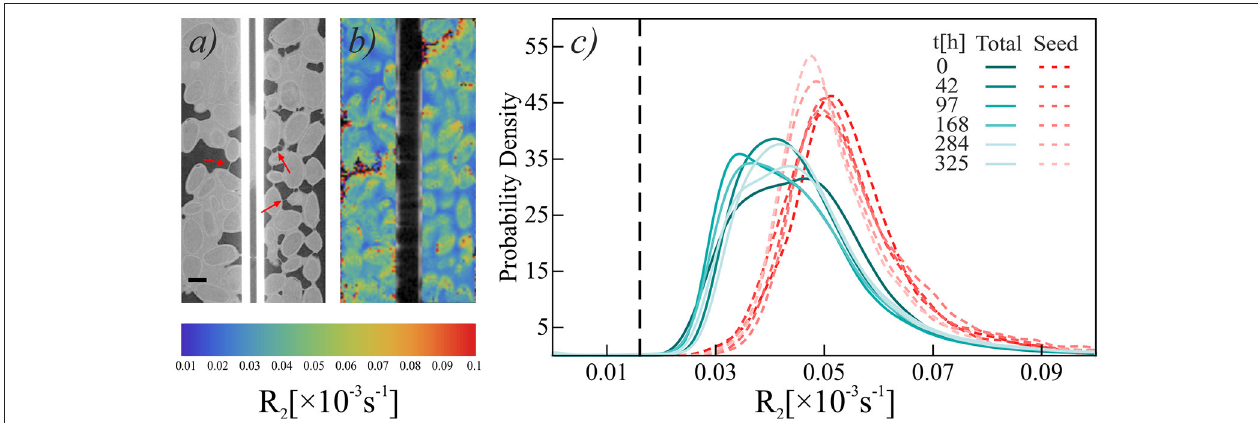
FIGURE 2 | Aligned CT (a) and NMR (b) scans of pure chia seeds at t = 325h. Scale bar at bottom left of the CT image is 1mm. X-ray CT images show filaments spanning across air-filled voids (red arrows). Colors in the NMR image indicate relaxation rate R 2 . (c) Histograms of relaxation rate R 2 of pure chia. Blue-green solid lines show R 2 in “Total” region, red dashed lines show R 2 in “Seed” region. Black dashed reference line shows mean R 2 of water in the capillary. Note that the thickness of a single MRI slice is 500 µ m compared to 20 µ m of X-ray CT, which results in a perceived misalignment of geometrical features.